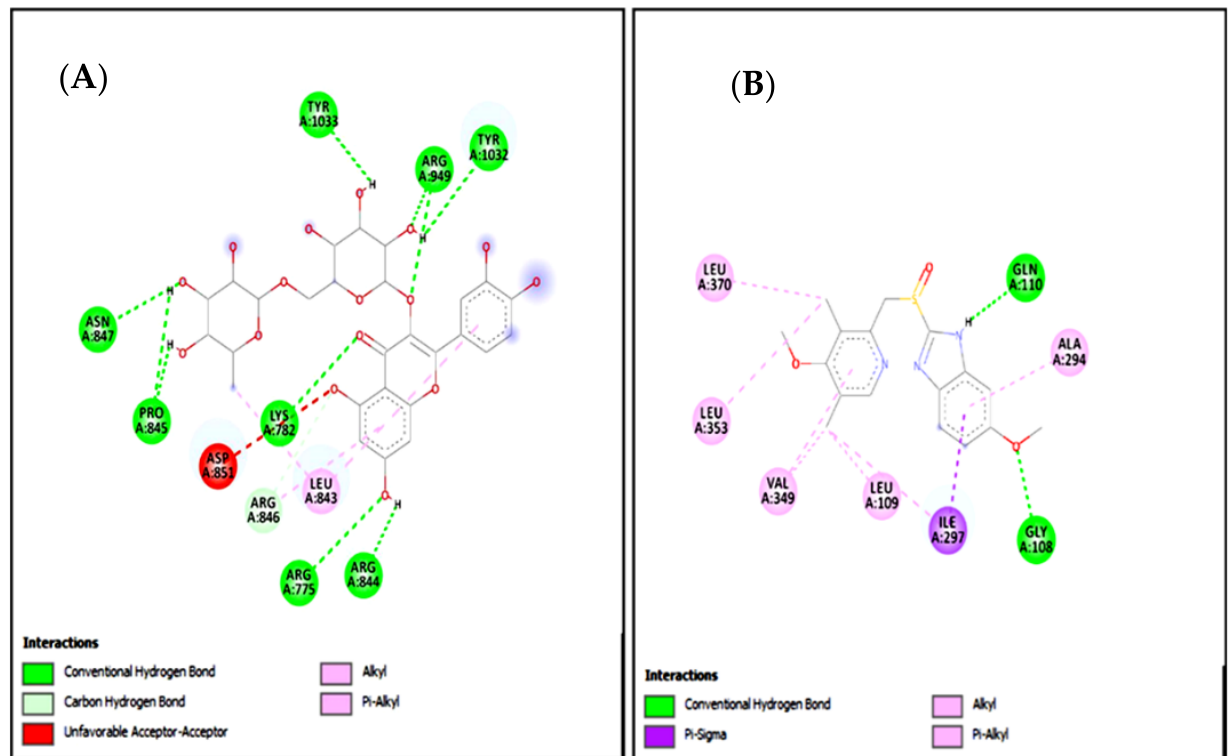
Figure 16. ( A , B ) represents 2D interactions of rutin and omeprazole against the target: H + /K + -ATPase respectively, evaluated through Biovia Discovery Studio 2016.